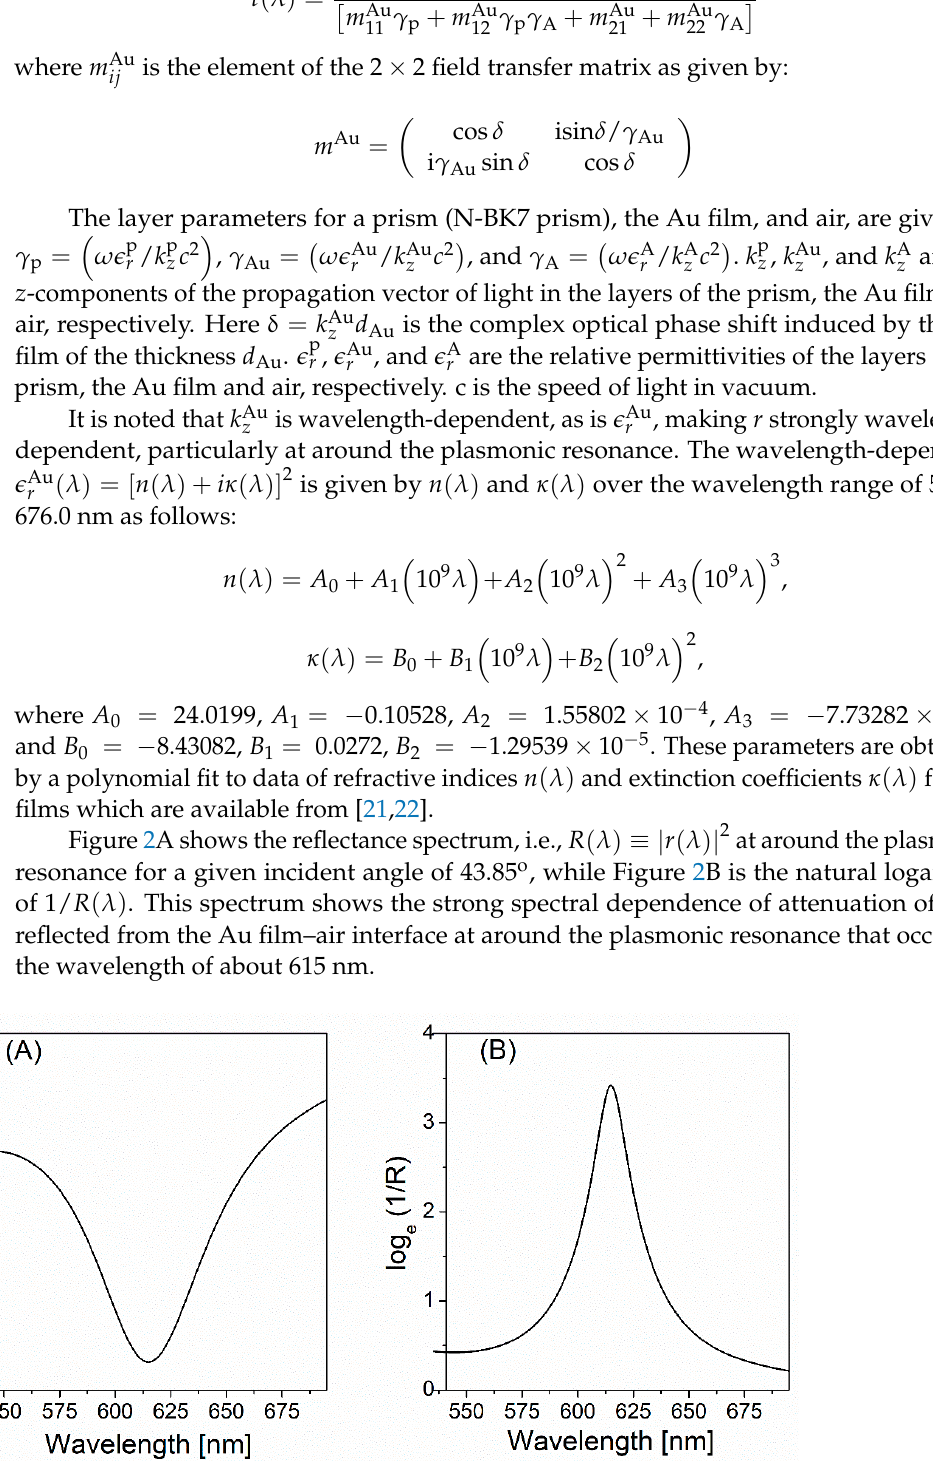
Figure 3. The wavelength dependence of the phase shift of the reflected and transmitted electric fields calculated using a field transfer matrix formula Equations (1) and (2), respectively. 3. Phase Dispersion Calculation with Kramers–Kronig Relation Let us consider the attenuated intensity of reflected light as the attenuated intensity of light transmitted through a virtual absorptive medium. The reflectance can thus be taken as the transmittance (cid:1846) , enabling log (cid:2915) [1/(cid:1844)] to be treated as absorbance or optical density, OD = log (cid:2915) [1/(cid:1846)] for the virtual medium. In general, physical causality dictates that the complex function (cid:2031)((cid:2033)) = (cid:2031) (cid:4593) ((cid:2033)) + (cid:1861)(cid:2031) (cid:4593)(cid:4593) ((cid:2033)) (as a function of a real frequency) requires a pair of the cross-coupled integral equations, i.e., the KK relation as follows [1–3]: (cid:2031) (cid:4593) (ω) = 2 (cid:2024) (cid:1842) (cid:3505) (cid:2031) (cid:4593)(cid:4593) ((cid:2033))(cid:2033)′ (cid:2033)′ (cid:2870) − (cid:2033) (cid:2870) (cid:2998) (cid:2868) (cid:1856)(cid:2033)′